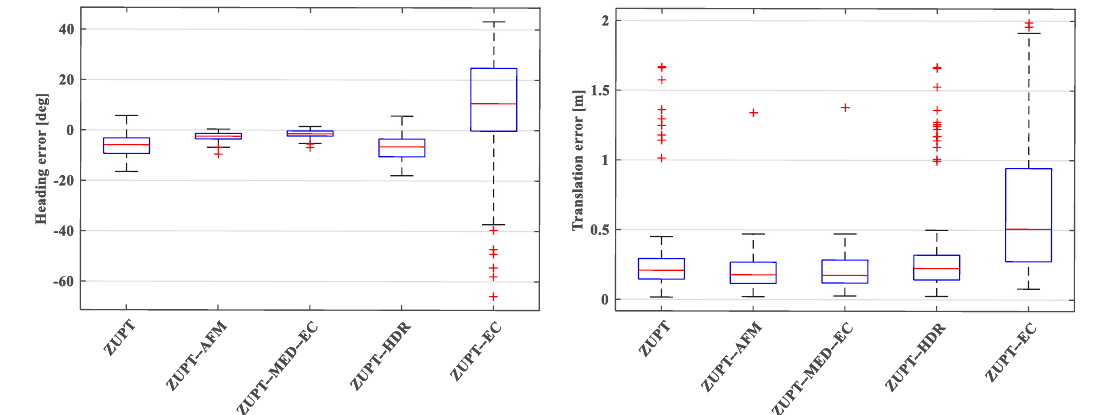
Figure 7. Heading error and translation error distributions of different frameworks.